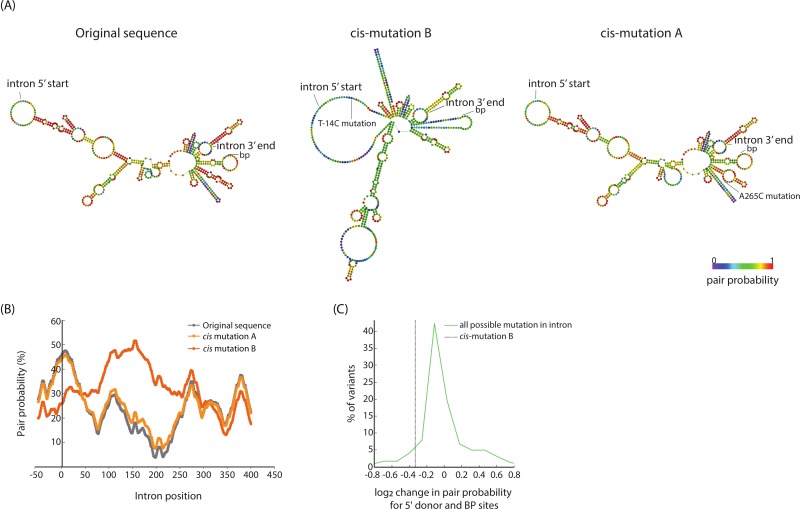
A secondary structure model of the effects of Cis mutation on splicing efficiency.(A) RNA secondary structure predictions using Vienna algorithm of the intron plus 50 bps of its surrounding exons for the original sequence and its two mutated versions. Cis-mutation B reshapes the predicted secondary structure and lowers the base pairing probability around the 5′ donor and branching point sites. (B) Base pairing probability at all positions as calculated by the Vienna algorithm for the original intron sequence and its two mutated versions. Position of 5′ donor site is 0, position of branching point site is 328, position of 3′ acceptor site is 361, position of mutation A is 265, position of mutation B is −14. (C) Probability distribution of the log2 of change in base pairing probability along a 20-base window at the 5′ donor and branching point sites for all possible single nucleotide variations on the intron's sequence compared with the original sequence. Vertical line denotes the value of the observed cis-mutation B, which is at the bottom 5.5 percentage of the histogram; i.e., it is among mutations that mostly reduce the base pair probability at these sites.